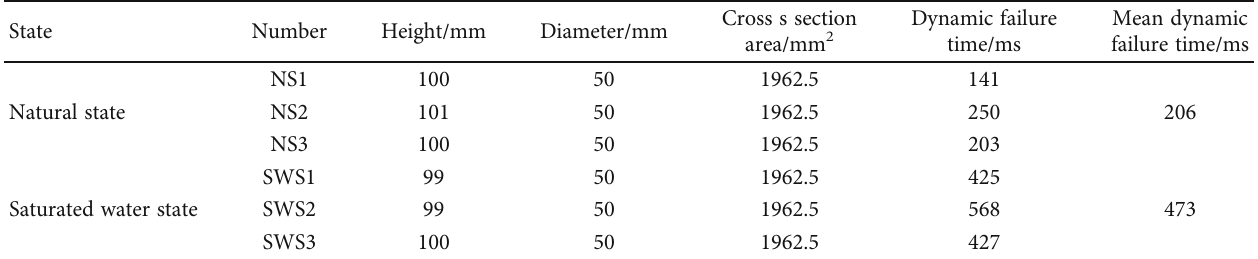
ff erent states. T ) under di